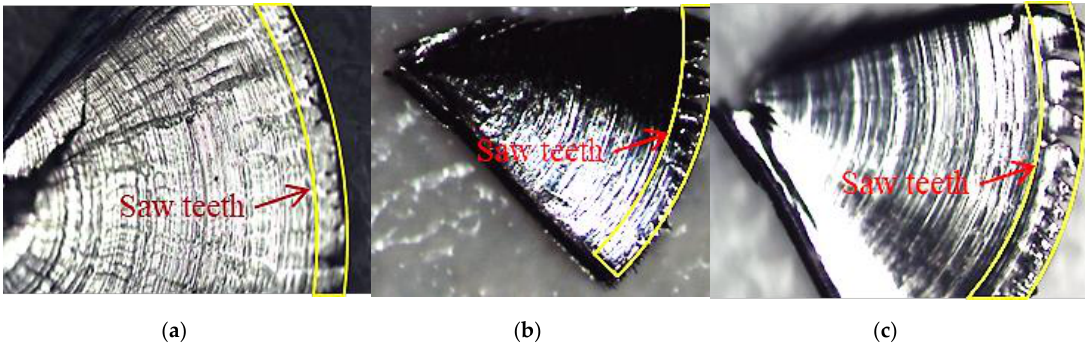
Figure 14. Chip morphology during finish milling of L-PBF manufactured Inconel 625 under different cutting conditions: ( a ) v c = 90 m/min, f = 0.1 mm/tooth/rev in the XY plane, ( b ) v c = 30 m/min, f = 0.2 mm/tooth/rev in the XY plane, ( c ) v c = 30 m/min, f = 0.15 mm/tooth/rev in the XY plane when milling the workpiece built with the SSR of 90°.